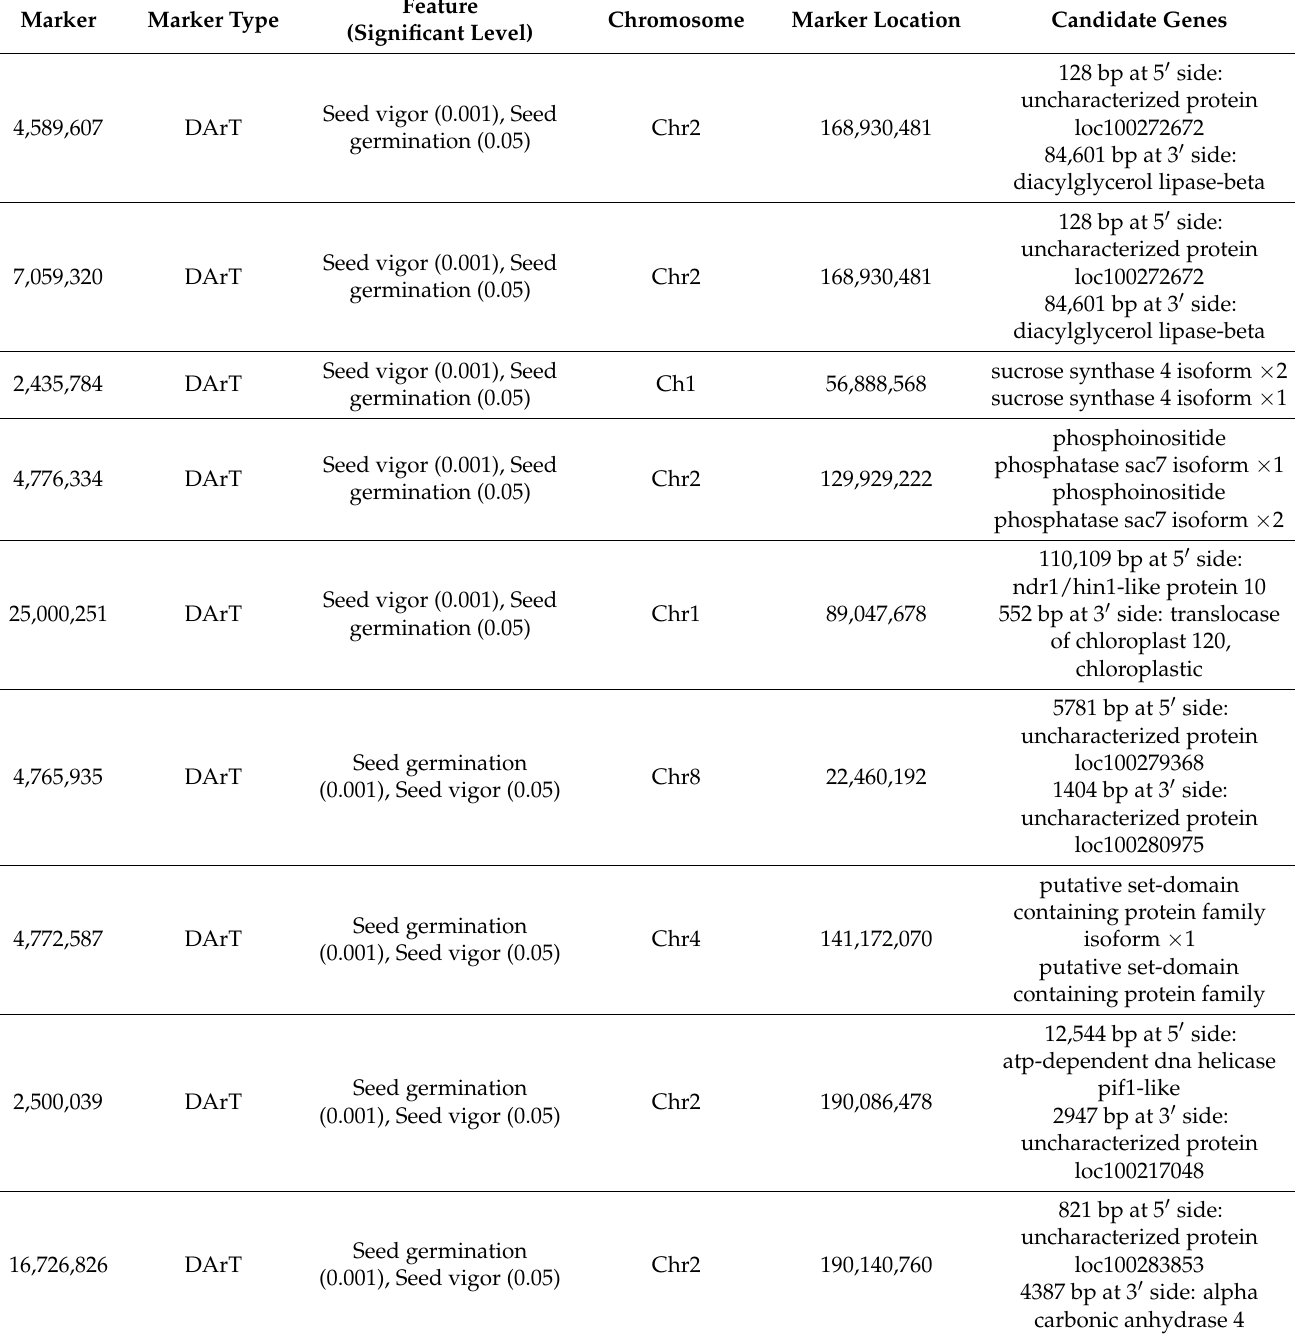
Table 5. Characteristics and location of markers significantly related to the analyzed